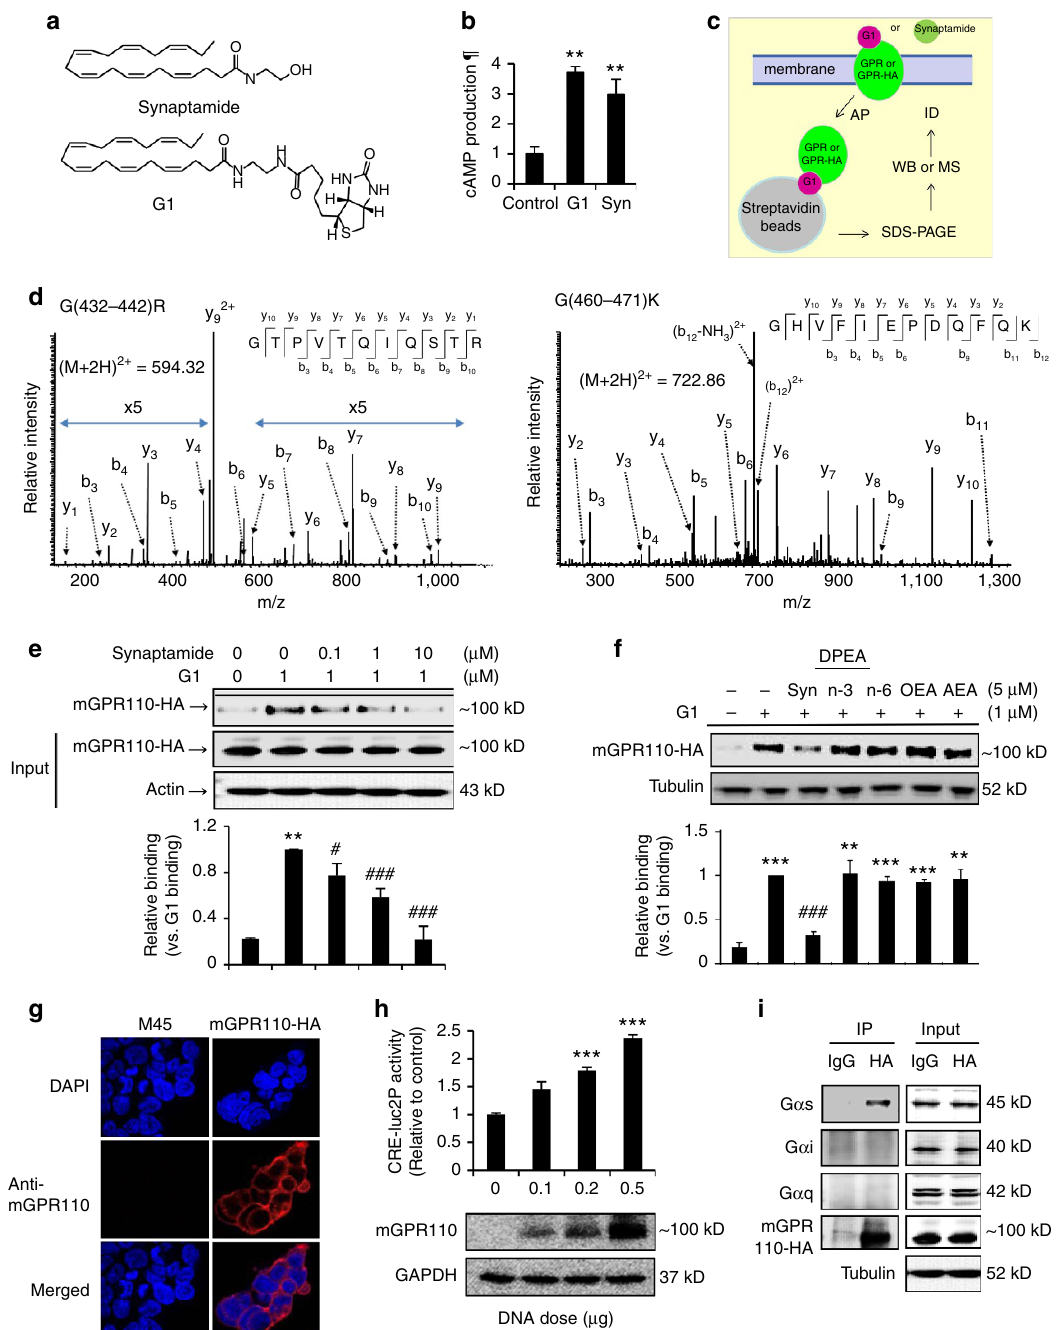
Figure 2 | Identification of synaptamide receptor and associated G-protein. Biotinylated synaptamide analogue G1 ( a ) increased cAMP production in DIV3 neurons after 10min stimulation ( b ). After mouse fetal brains or NSCs were lysed in PBS containing 0.5% Triton X-100, treated with G1, affinity-purified using streptavidin beads and subjected to SDS/PAGE, the entire gel was cut into several bands for tryptic digestion and protein identification (ID) by mass spectrometric analysis ( c ). The MS/MS spectra of GPR110 peptides G(432–442)R and G(460–471)K detected from the gel band in the 100–130kD molecular weight region are shown ( d ). Binding of G1 to GPR110 was confirmed by the western blot detection of mGPR110-HA expressed in HEK cells at B 100kD after streptavidin pull-down while synaptamide dose-dependently decreased the mGPR110-HA recovered after G1-streptavidin pull-down ( e ). Among fatty acid ethanolamides, only synaptamide displaced the G1 binding to mGPR110 ( f ). GPR110 expression in the plasma membrane was detected ( g ). The cAMP response induced by 10nM synaptamide increased in a GPR110 gene-dose-dependent manner ( h ). GPR110 interaction with G a s was identified by co-immunoprecipitation of overexpressed mGPR110-HA with endogenous G a s ( i ). Syn, synaptamide; n3, omega-3; n6, omega-6; DPEA, N -docosapentaenoylethanolamine; OEA, N -oleoylethanolamine; AEA, N -arachidonylethanolamine. Results in d and i represent two independent experiments. Data in ( b , e , f , h ) are means ± s.e.m. of biological triplicates ( n ¼ 3), representing three independent experiments. ** P o 0.01, *** P o 0.001 versus control, and # P o 0.05, ## P o 0.01, ### P o 0.001 versus G1 binding by unpaired Student t -test. z , relative to control. Scale bar, 5 m m ( g